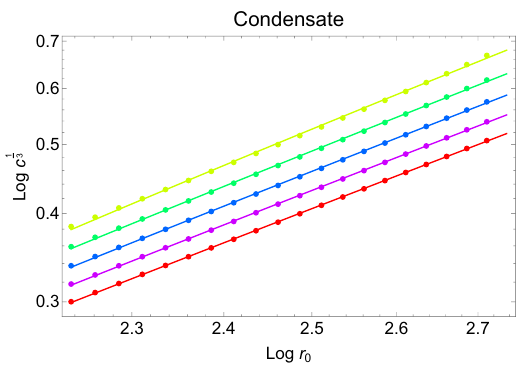
Figure 19 . Condensate vs temperature for straightish branes in black hole geometry r m